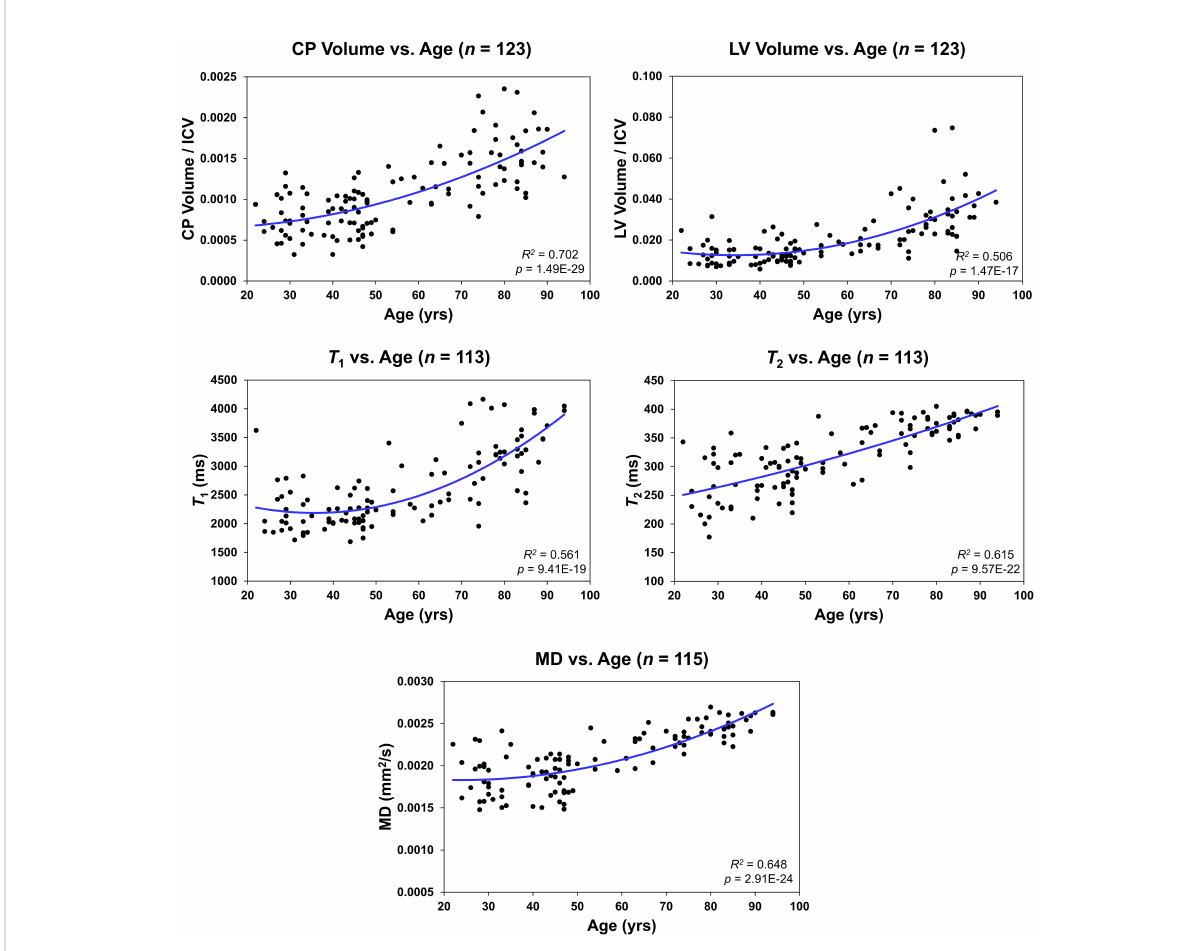
FIGURE 3 Regressions of choroid plexus (CP) volume/intracranial volume (ICV), lateral ventricle (LV) volume/ICV, T 1 , T 2 , or mean diffusivity (MD) with age. For each plot, the coef fi cient of determination, R 2 , and p-value, p , are